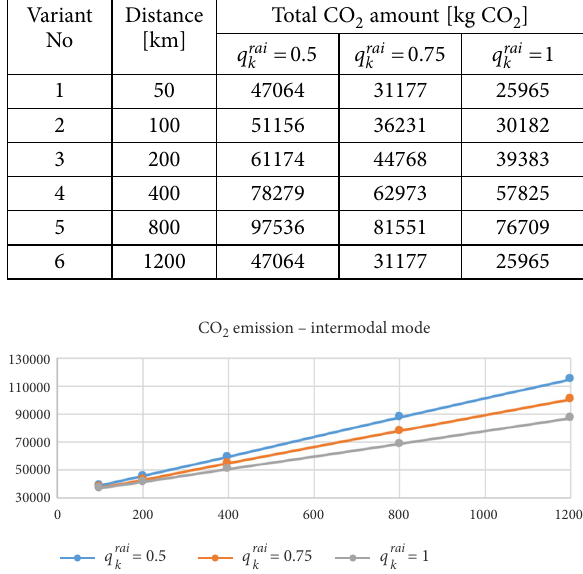
Figure 7. Increment of carbon emission in relation to train